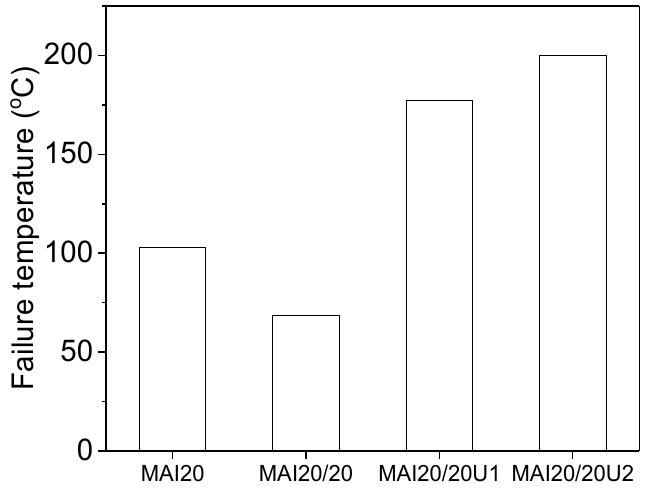
Figure 13. SAFT result on the SiUDMA-modified MAI20 series.